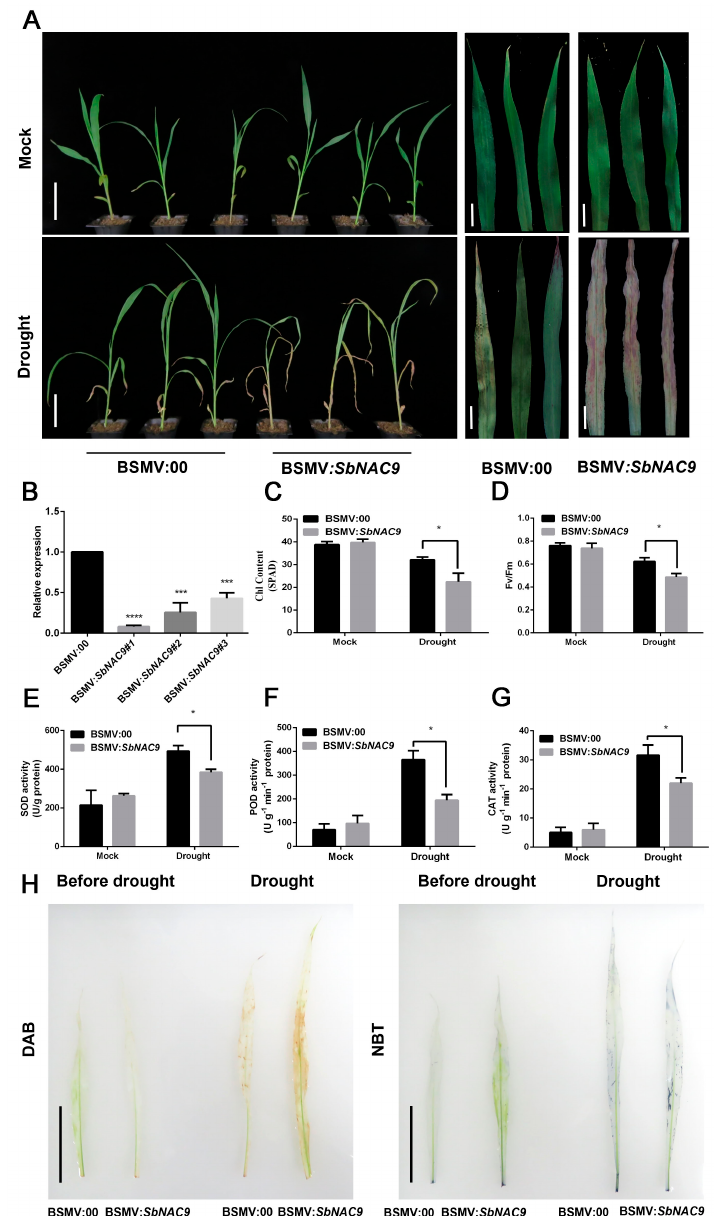
Figure 4. Silenced SbNAC9 weakened drought-stress tolerance of sorghum. ( A ) Phenotype of sorghum seedlings inoculated with BSMV:00 and BSMV: SbNAC9 under mock and drought-stress treatments. Bars indicate 6 cm for the whole plants in the left panels and 2 cm for the leaves in the middle and right panels. ( B ) Relative transcript level of SbNAC9 in sorghum seedlings silenced by VIGS. SbEIF4A was used as the internal reference. Error bars indicate SD of three independent experiments. **** p < 0.0001 and *** p < 0.001 by Student’s t -test. ( C , D ) Chlorophyll content ( C ) and chlorophyll fluorescence Fv/Fm ( D ) in the third leaf of sorghum seedlings inoculated with BSMV:00 and BSMV: SbNAC9 under mock or drought-stress treatments. Error bars indicate SD of three independent experiments. * p < 0.05 by Student’s t -test. ( E – G ) SOD ( E ), POD ( F ), and CAT ( G ) activities in sorghum seedlings inoculated with BSMV:00 and BSMV: SbNAC9 under mock or drought-stress treatments. Error bars indicate SD of three independent experiments. * p < 0.05 by Student’s t -test. (H) DAB and NBT staining of leaves of sorghum seedlings inoculated with BSMV:00 and BSMV: SbNAC9 under drought-stress treatment for 5 days. Bars indicate 5